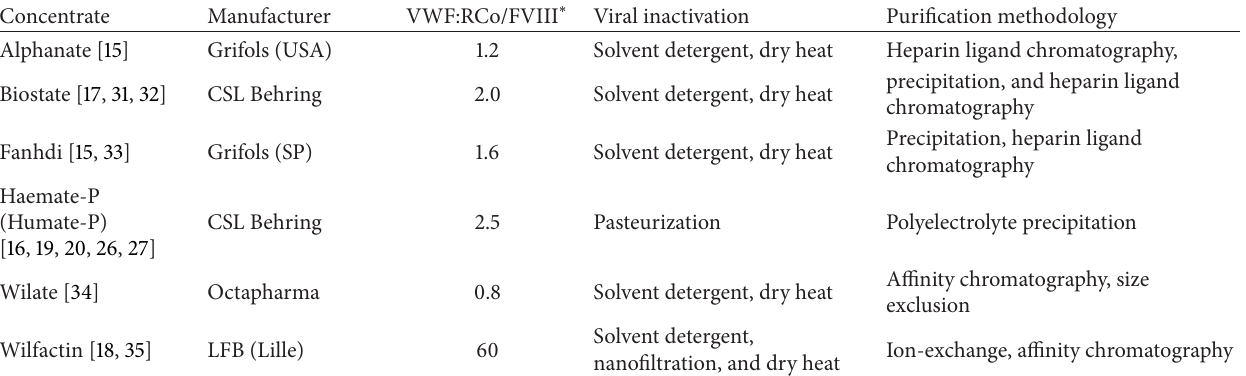
Table 2: VWF:FVIII concentrates validated in clinical studies involving relatively large number of VWD patients. Concentrate